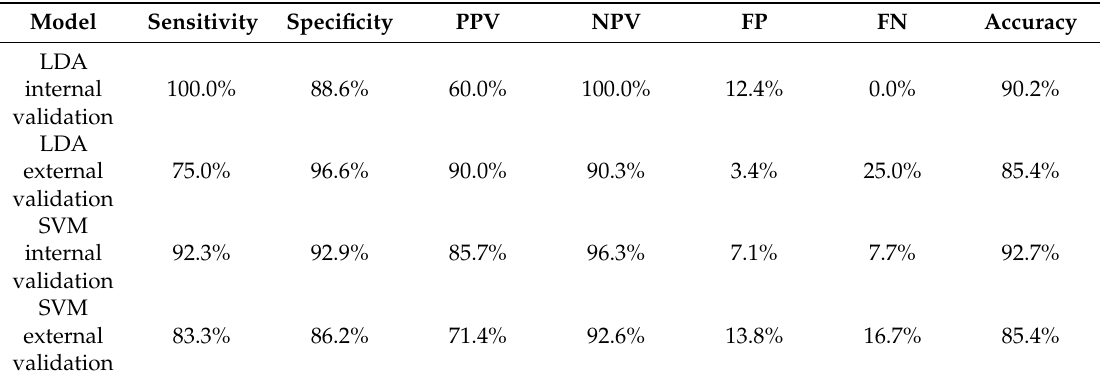
Table 2. Diagnostic accuracy of the E-nose.